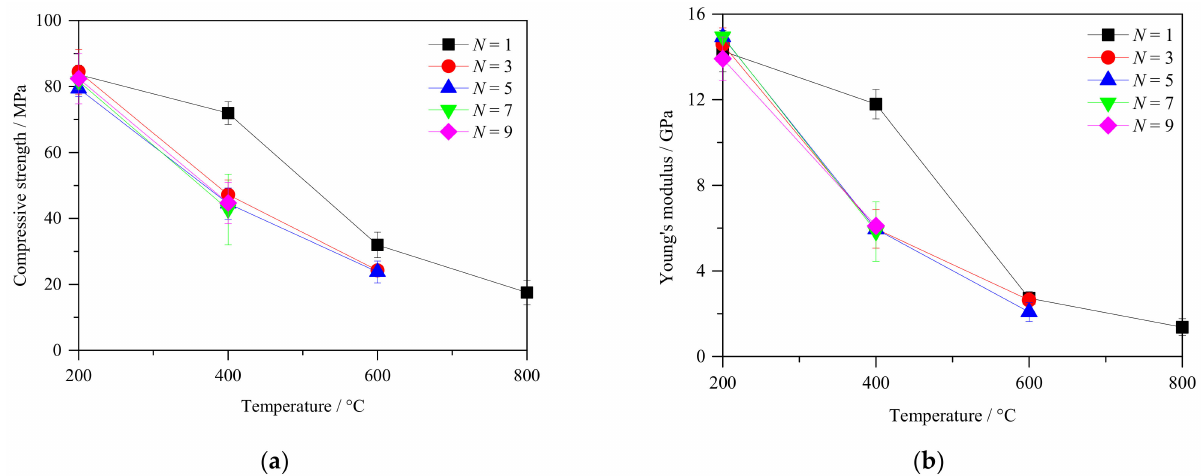
Figure 8. Influence of temperature levels on the ( a ) compressive strength and ( b ) Young’s modulus (The error bar represents the standard deviation).